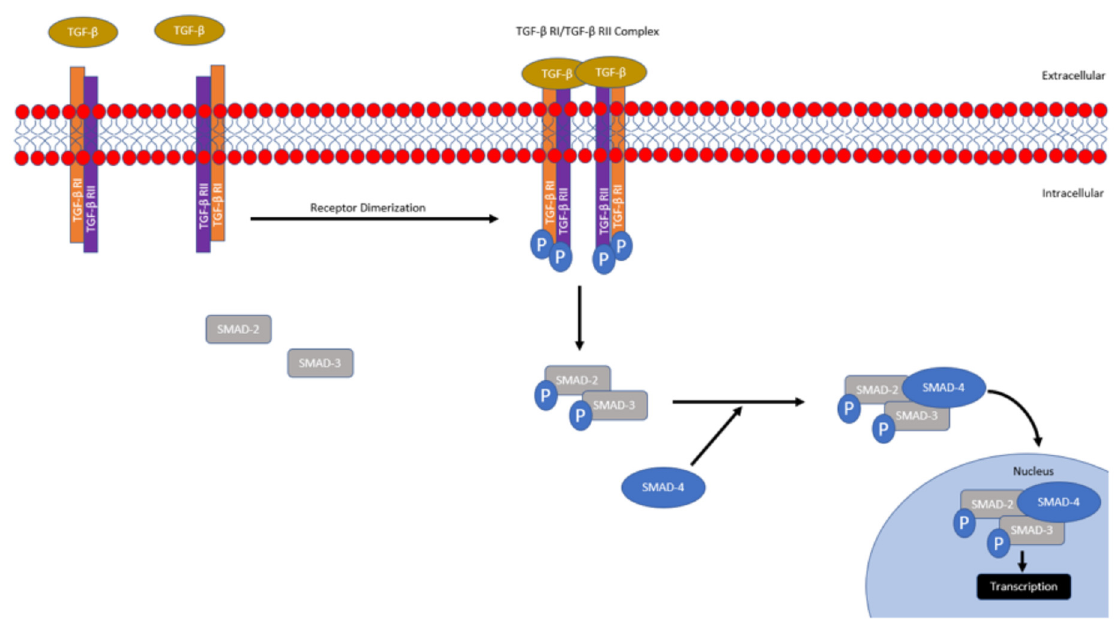
Figure 1. Overview of Conventional SMAD-mediated TGF- β Signaling. Activated TGF- β binds and promotes the dimeri- zation of TGF- β type 1 and type 2 receptors, which leads to the phosphorylation and subsequent activation of the TGF- β type 1 receptor. Activated TGF- β type 1 receptor then phosphorylates SMAD 2 and 3, promoting complex formation with co-SMAD (SMAD4). The SMAD trimer complex then translocates into the nucleus, where it promotes